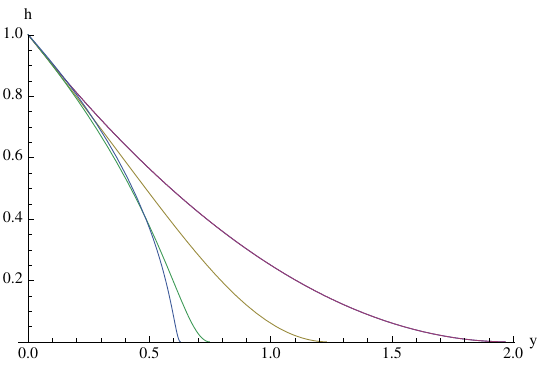
Figure 4 . Pro(cid:12)le function of charge one BPS baby Skyrmions for the the baby potential (cid:22) = (cid:21) = 1 and (cid:3) = 1, for di(cid:11)erent values of the gravitational constant: (cid:20) 2 = 0 ; (cid:20) 2 = 3 ; (cid:20) 2 = 5 and (cid:20) 2 = 5 : 89 which is the extremal limit | lines: red, yellow, green and blue